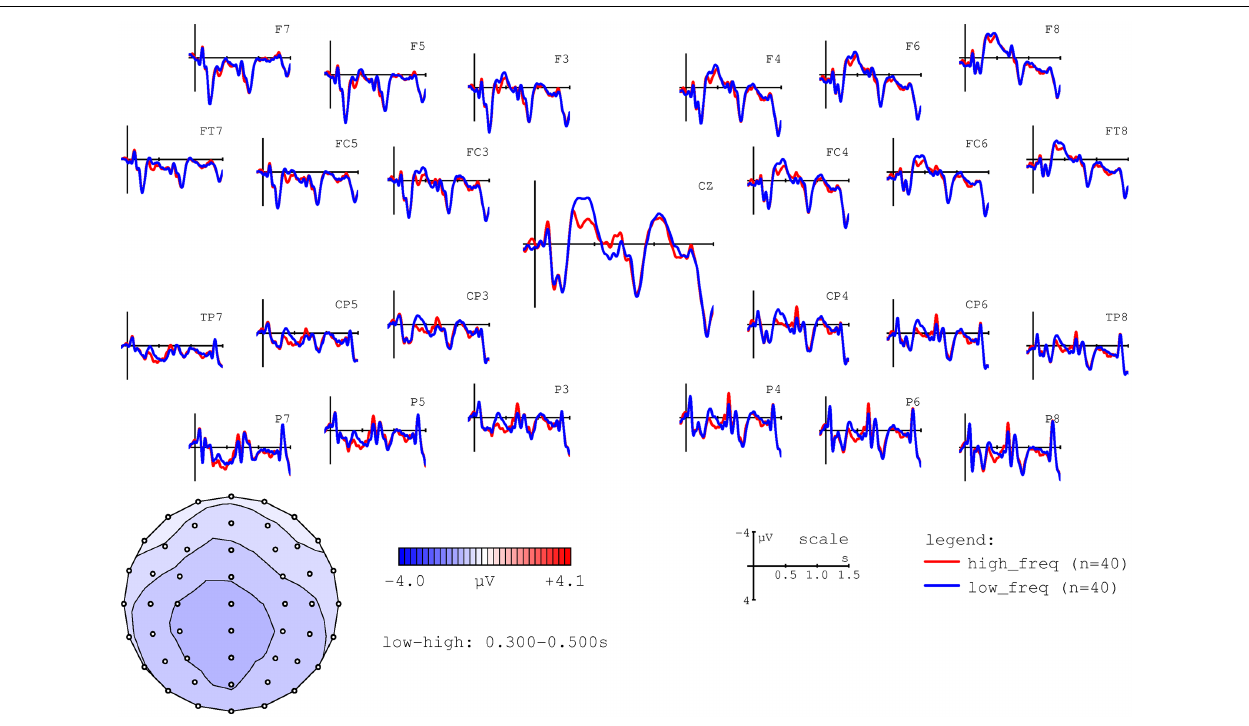
FIGURE 3 | Grand average ERPs time-locked to the second NP (onset at the vertical bar) for high (red line) and low frequency (blue line) nouns. Negativity is plotted upward.The voltage map shows the topography of the effect (amplitudes for low – high frequency nouns in the 300–500 ms time window).